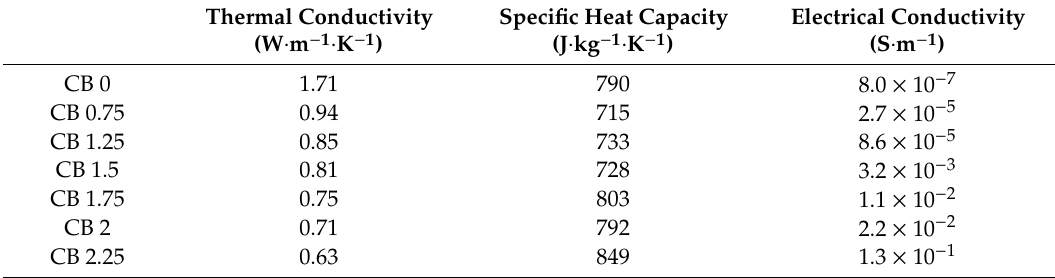
Table 4. Thermal and electrical properties of the studied